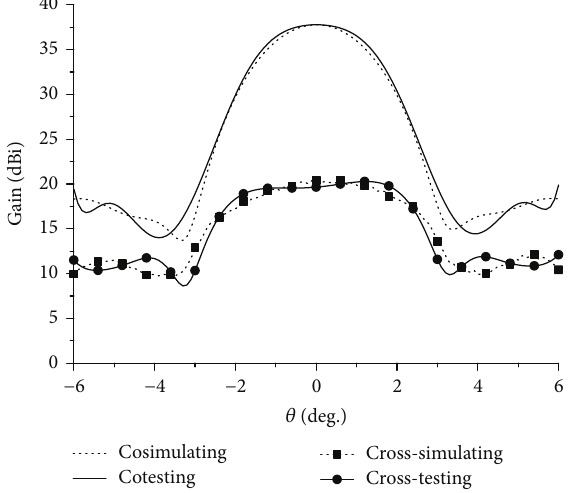
Figure 8: Simulating and testing radiation pattern in 𝜑 = 0 ∘ plane.